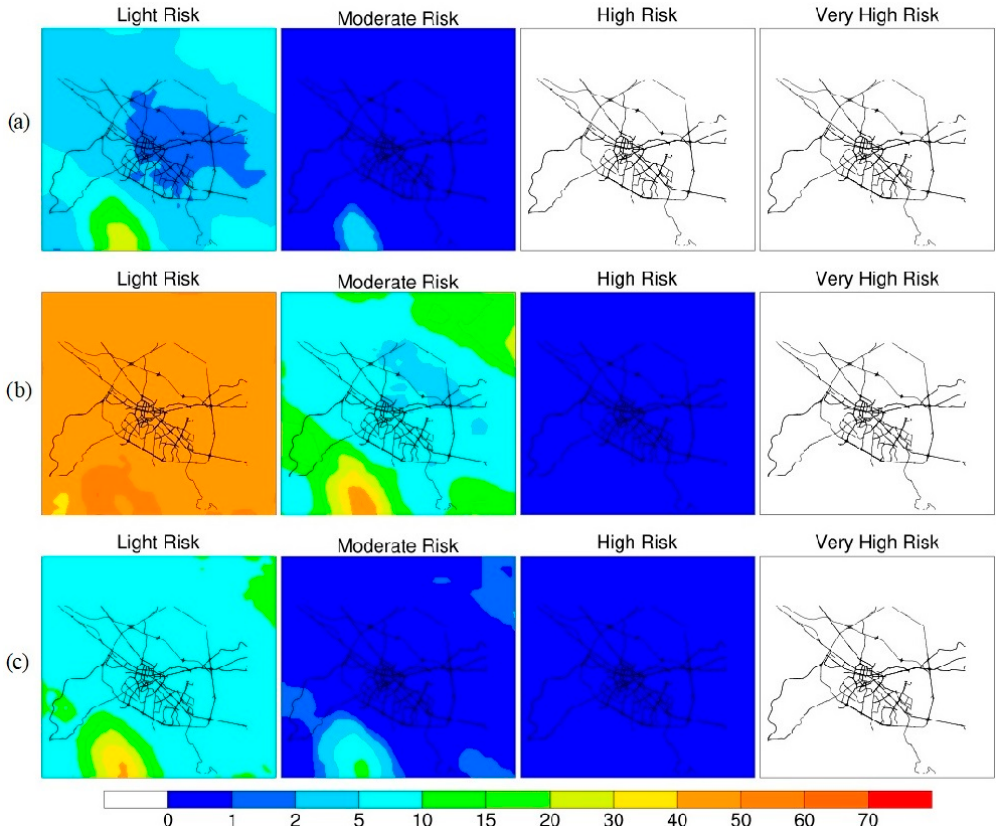
Figure 10. Frequency (in %) for ( a ) autumn, ( b ) winter, and ( c ) spring of the Wind-chill index categories “Low risk” (first column), “Moderate risk” (second column), and “High risk” (third column) in the Sofia region at 15 UTC during the autumn (first row), winter (second row), and spring (third row).